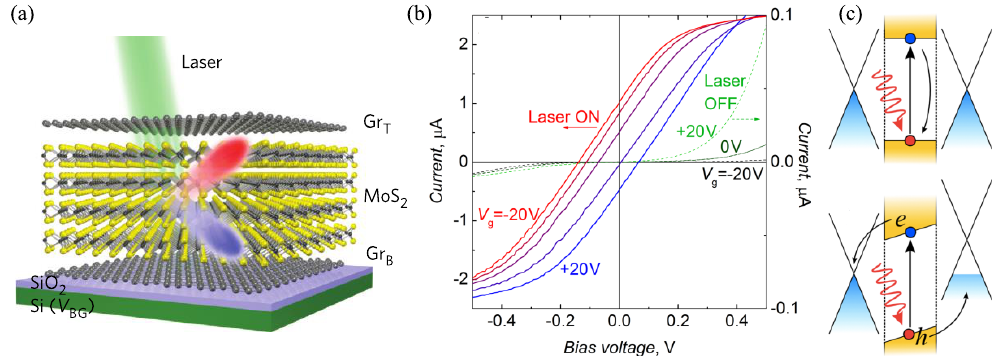
Figure 4. ( a ) Schematic drawing of a graphene-TMD-graphene photodetector. Reproduced with permission from [59], Copyright Nature Publishing Group, 2013. ( b ) Electrical characteristics with and without optical illumination. Reproduced with permission from [60], Copyright The American Association for the Advancement of Science, 2013. ( c ) Schematic band diagrams for symmetric graphene doping (upper image; no photoresponse without bias) and asymmetric doping (lower image; charge separation due to built-in electric field). Reproduced with permission from [60].